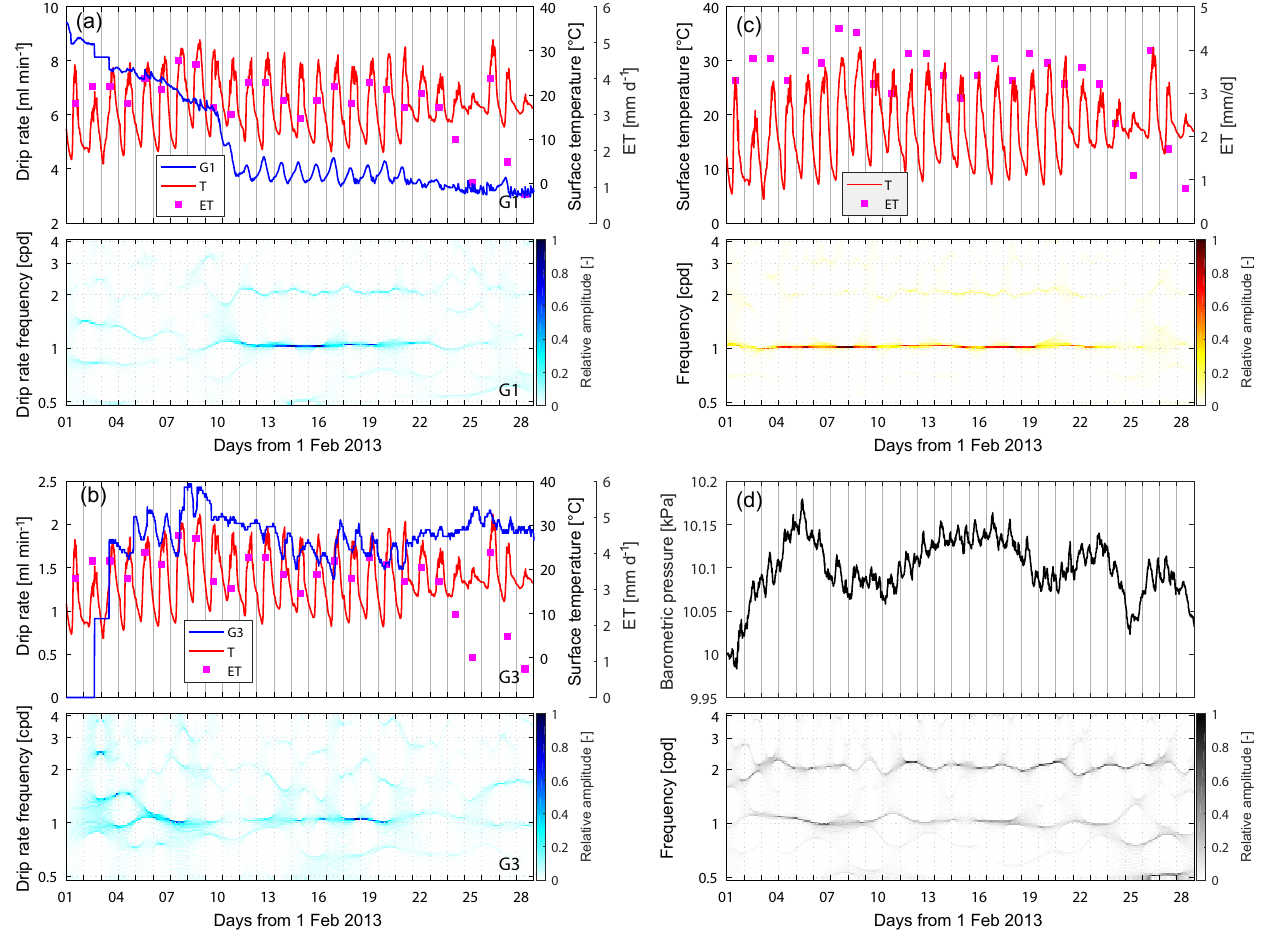
Figure 4. The raw drip rate, evapotranspiration and surface temperature data with the corresponding drip rate WSST plot for time periods where a 1cpd signal is present for sites (a) G1 and (b) G3 , (c) surface air temperature ( T ) and potential evapotranspiration (ET) and (d) barometric pressure for period February